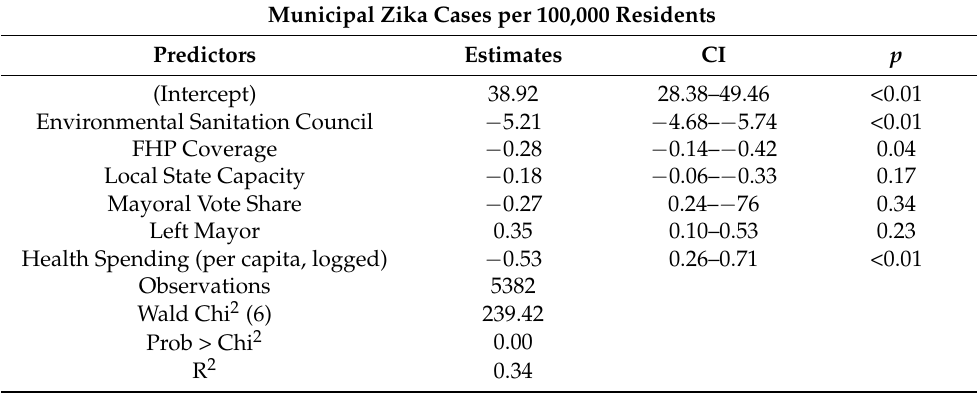
Table 1. This table reports the results of negative binomial estimation following pre-processing through Coarsened Exact Matching.